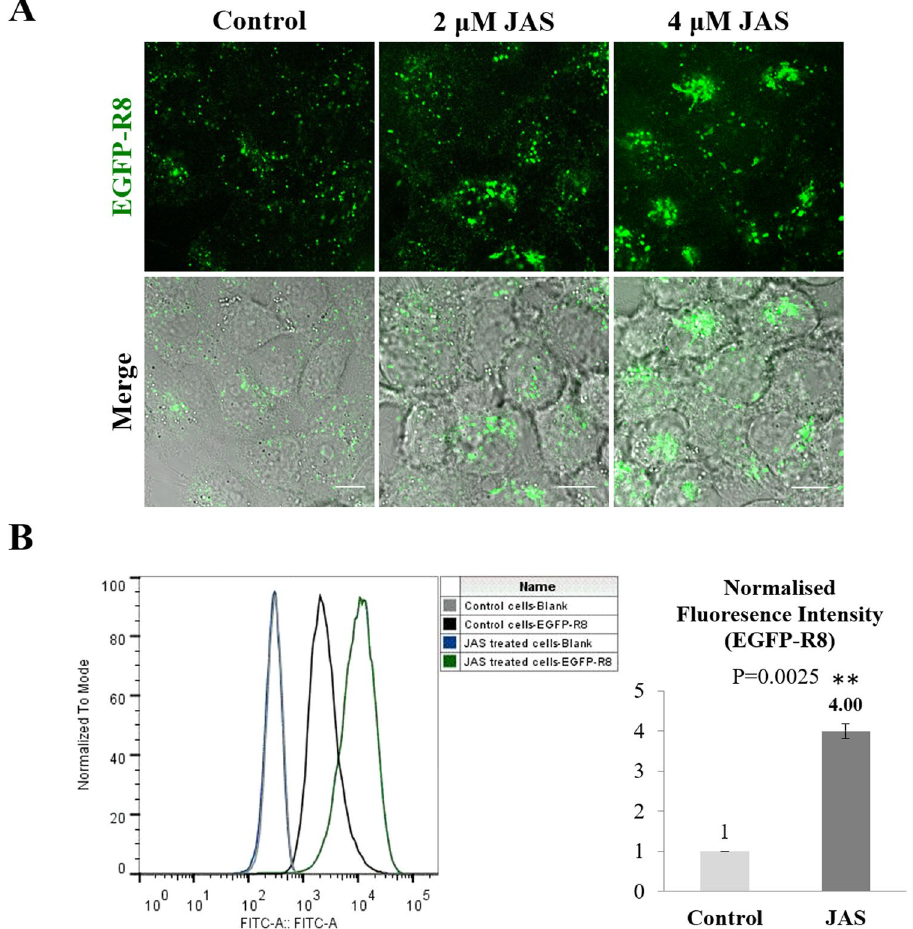
Figure 6. Effects of JAS on the cellular uptake of EGFP-R8 in A431 cells. Cells were preincubated with diluent control or 2–4 µ M JAS for 45 min prior to incubation with 2 µ M EGFP-R8 for 1 hr in the absence (control) or presence of 2–4 µ M JAS and washed thoroughly using heparin. ( A ) Cell associated fluorescence was analysed using confocal microscopy and shown are single projection images of fluorescence only (top row) and merges of fluorescence and DIC of the same cells. Scale bars 10 µ m. ( B ) Cells treated as in A with 4 µ M JAS were then washed, collected and analysed by flow cytometry. Data represent the mean of geometric means ± S.D. from three independent